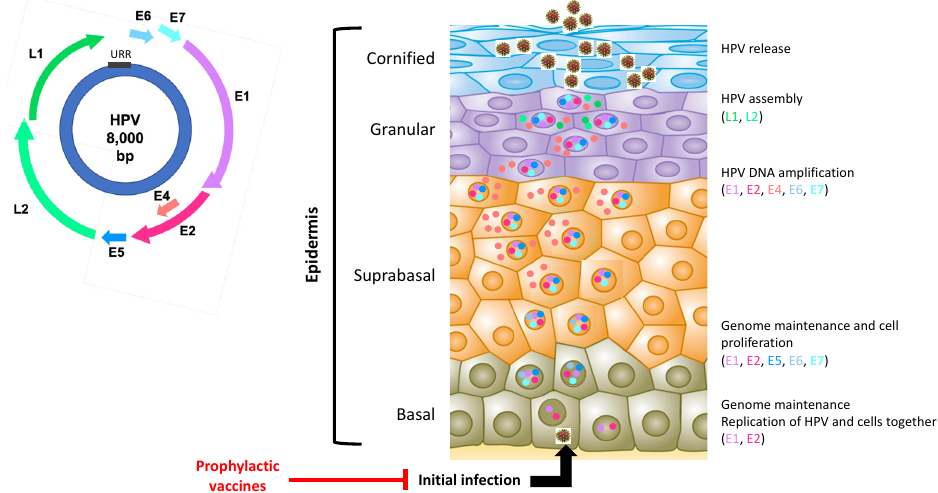
Figure 1. Human papillomavirus genome organization and viral life cycle. The HPV genome is composed of the early viral genes (E1, E2, E4, E5, E6, E7), the late viral genes (L1 and L2), and the upstream regulatory region (URR). The HPV life cycle is composed of several steps. First, the virus infects a keratinocyte of the basal layer of the epithelium. Second, the virus and the cell replicate together. As long as the cell is dividing, the expression of the viral genes is highly controlled. Third, when the cell stops dividing and begins to differentiate into a mature keratinocyte, the virus activates all its genes. The expression of the oncogenic genes is no longer regulated. Finally, in the upper layers of the epithelium, all viral genes are expressed, and the viral genomes are encapsidated. The encapsidated viral particles leave the cell.